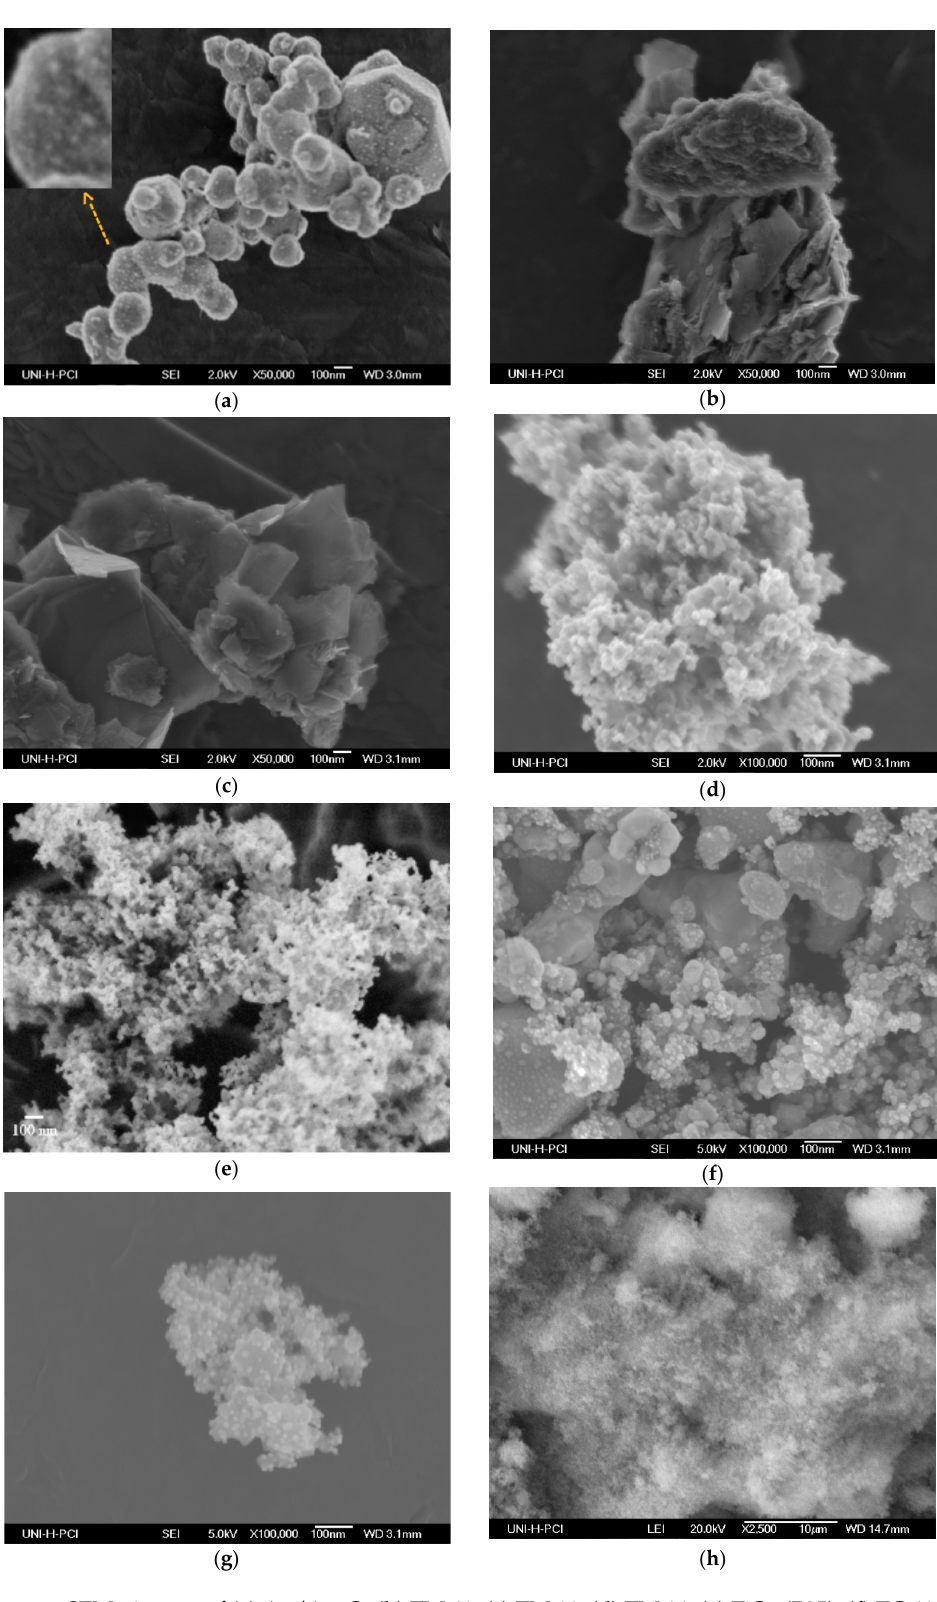
Figure 2. SEM pictures of ( a ) Ag/Ag 2 O, ( b ) TM 41, ( c ) TM 11, ( d ) TM 14, ( e ) TiO 2 (P25), ( f ) TC 41, ( g ) TC 11, and ( h ) TC 14.